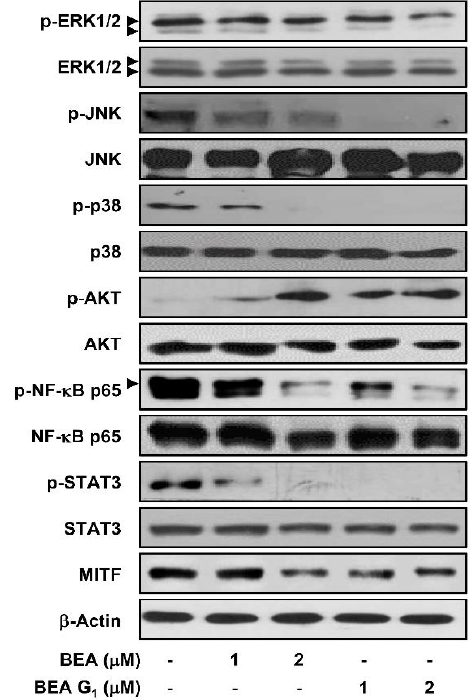
Figure 8. E ff ects of BEA and BEA G 1 on the activation of multiple molecular targets involved in the pathogenesis of melanoma. A375SM cells were treated with BEA and BEA G 1 (1 and 2 µ M) for 24 h, and protein levels were detected by Western blot analysis using specific antibodies. The levels of β -actin were used as an internal control. Arrowheads indicate bands that correspond to the specific protein.